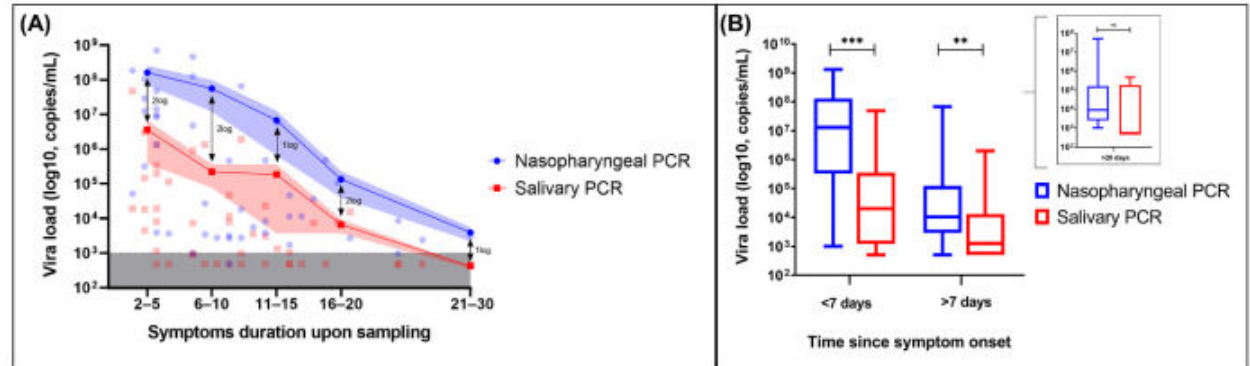
Figure 2. Viral load dynamics of NP RT-PCR versus saliva RT-PCR. ( A ) Kinetics of nasopharyngeal and salivary viral load according to symptom duration upon sampling. The lines connect the mean values of each period, and the shaded areas indicate the mean standard errors (SEM). The inferior grey shaded area represents the detection limit (1000 copies/mL). Specimens with undetectable viral load are shown within the grey dashed area. ( B ) Box and whisker plots comparing viral load between nasopharyngeal and salivary PCR on different periods since symptom onset. Boxes extend from 25th to 75th percentiles and whiskers show 5th and 95th percentiles. The lines in the middle of the boxes are plotted at median values. (Results were compared using Wilcoxon matched-pairs nonparametric test, *** = p < 0.001, ** = p < 0.01, ns = non-significant).